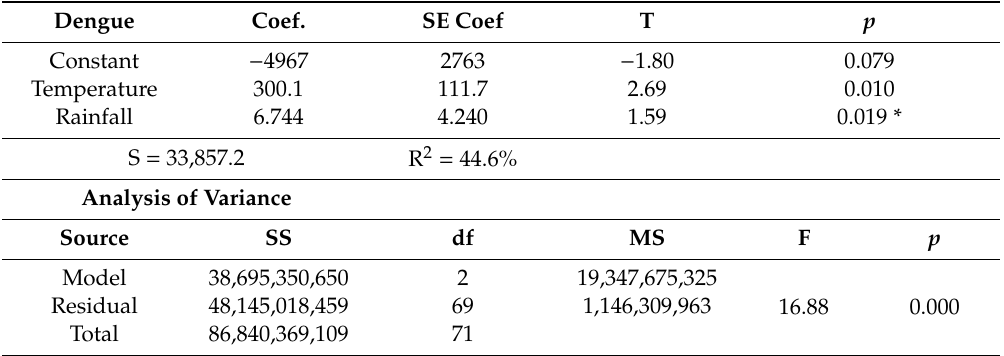
Table 5. Multiple regression analysis of monthly dengue versus mean monthly temperature and total monthly rainfall in Lahore.